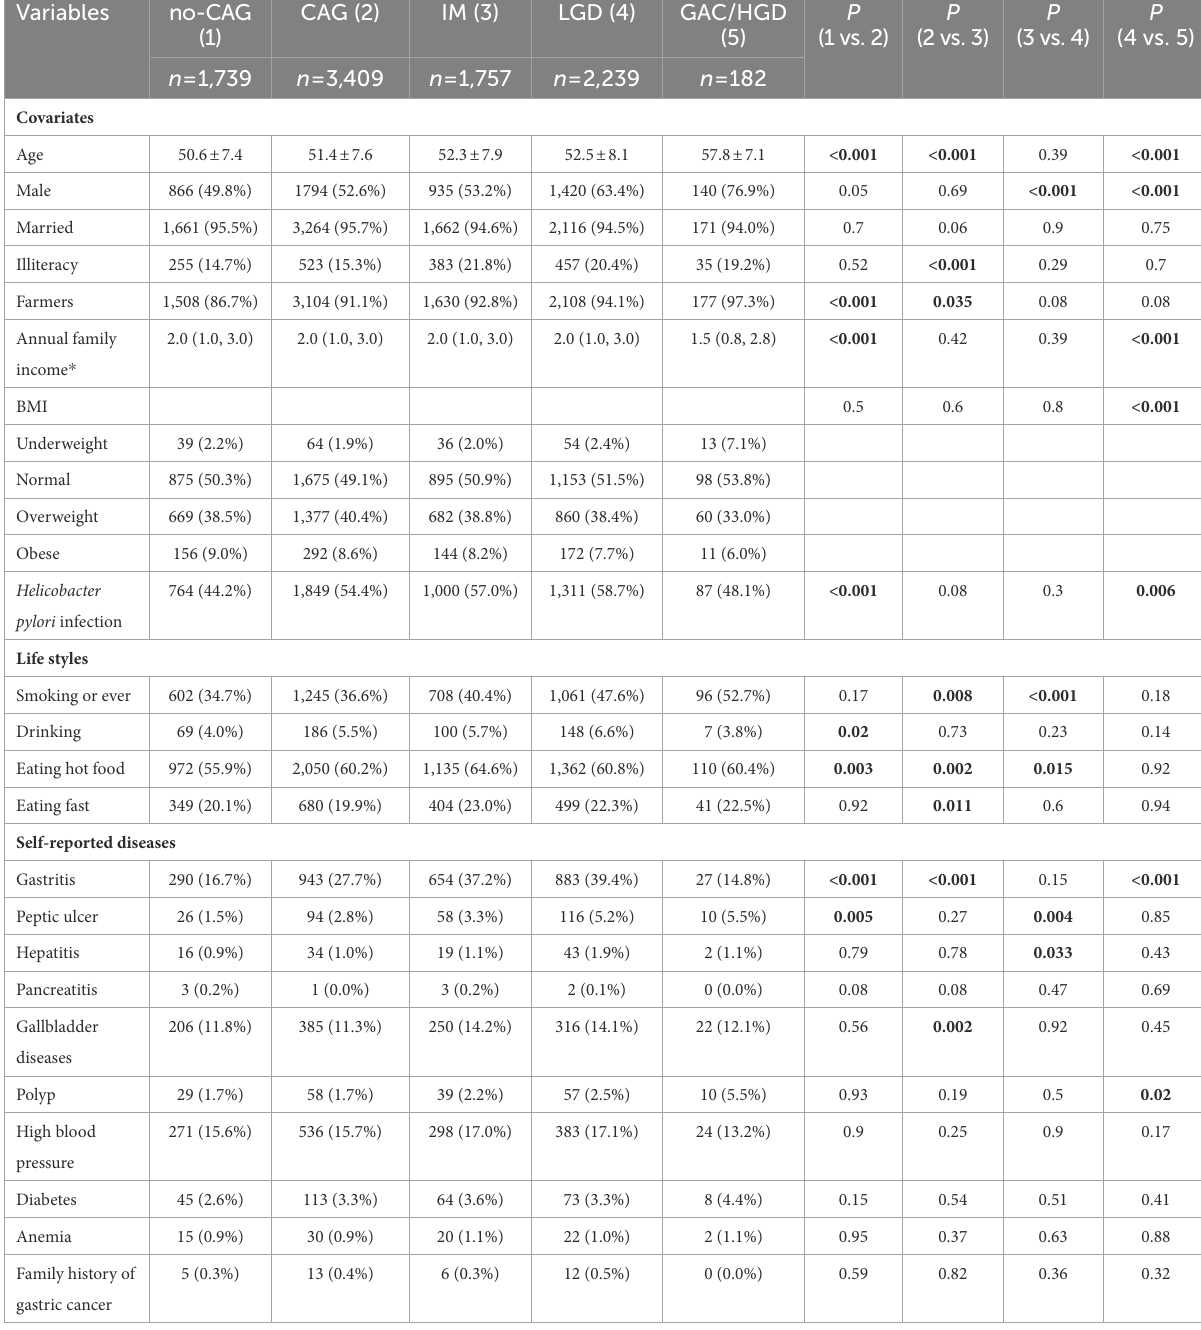
TABLE 1 Patients’